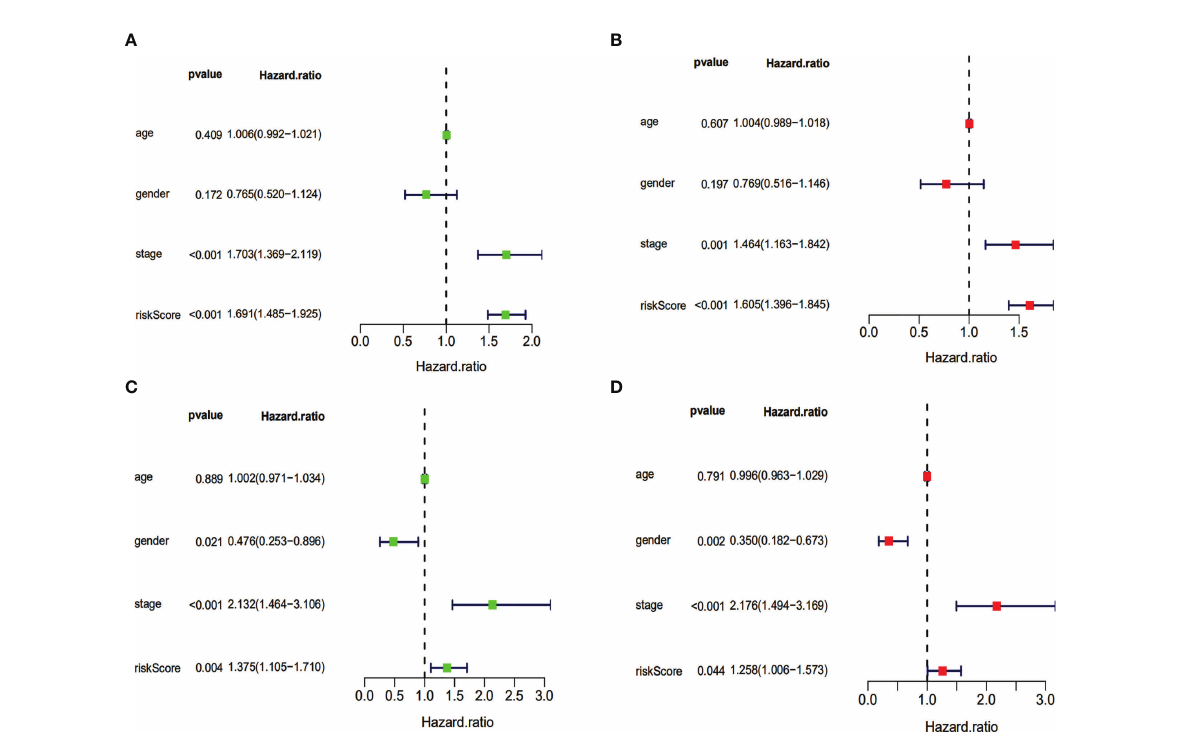
FIGURE 6 Univariate and multivariate independent prognostic analysis of independent risk factors for OS in patients with HCC. Univariate (A) and multivariate (B) in the TCGA dataset. Univariate (C) and multivariate (D) in the ICGC